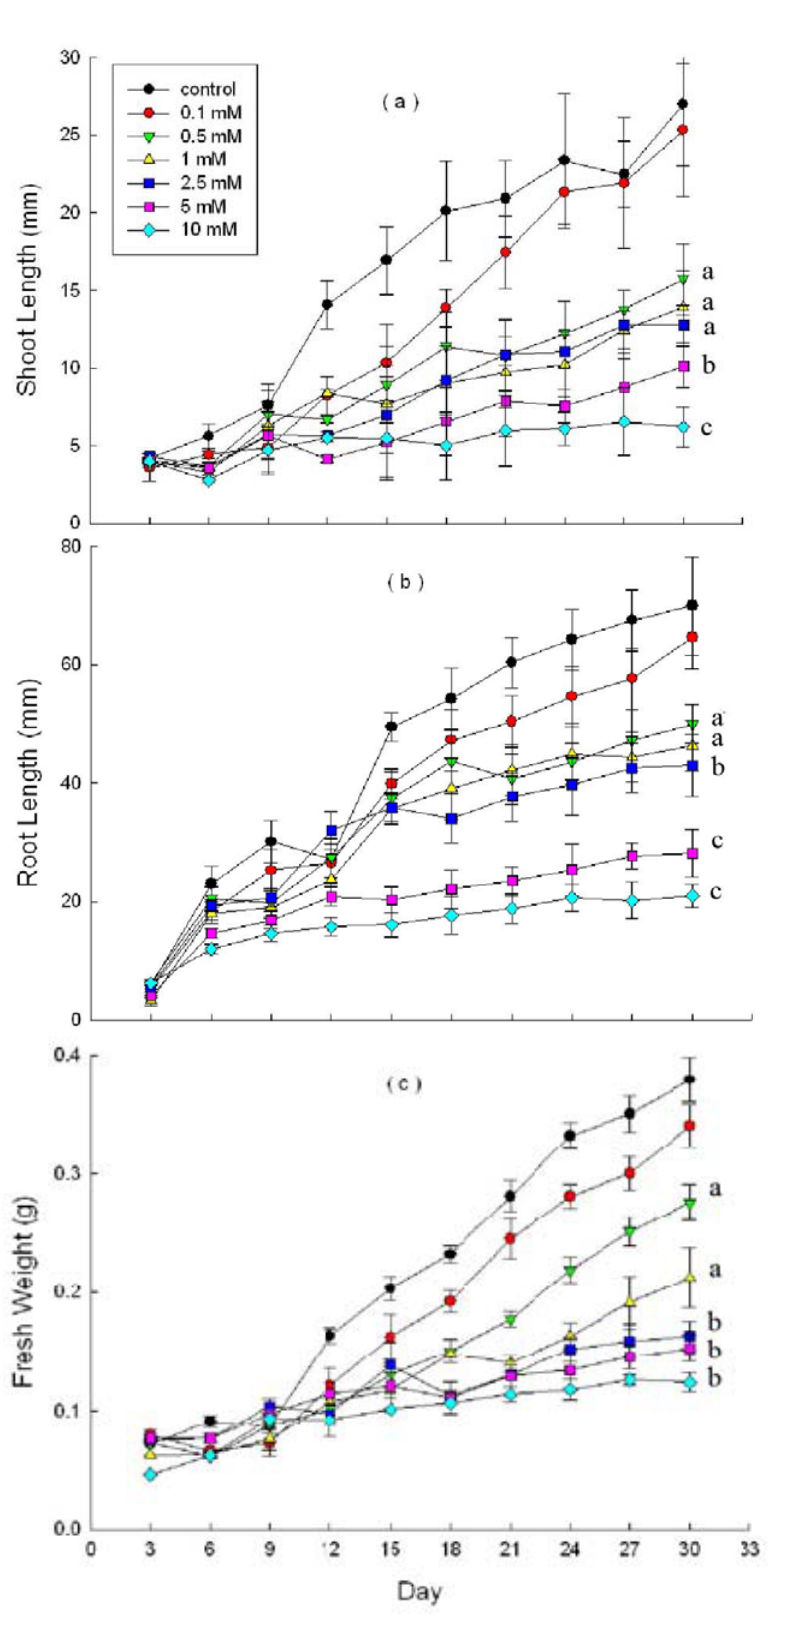
Figure 3. Effects of DHAP on shoot length ( a ), root length ( b ) and fresh weight ( c ) of P. schrenkiana ; Line graphs within the same plot followed by the same letter are not different at P = 0.05 level according to Fisher’s test; Each point is the mean of three replicates ±